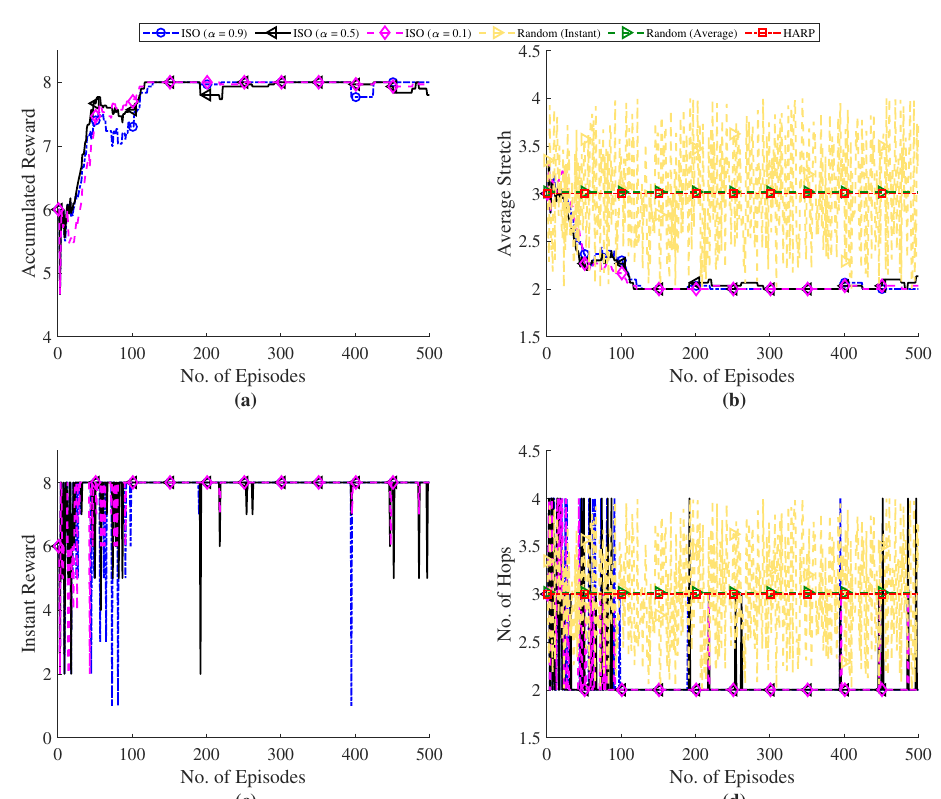
Figure 6. Stretch reduction and routing optimization progress of Q-learning agent at γ = 0.1: ( a ) Accu- mulated reward gain; ( b ) Average stretch gain; ( c ) Reward earned per episode; ( d ) Total hops/routers covered per